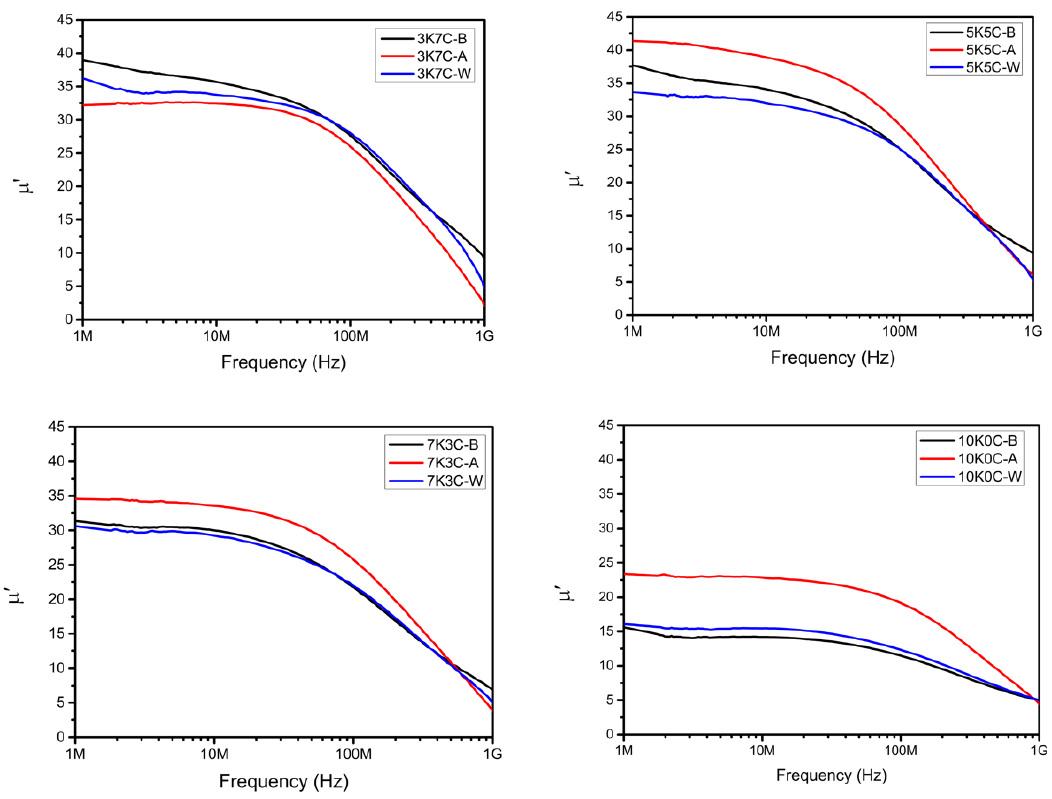
Figure 6. SEM image of the sample 5K5C-A.